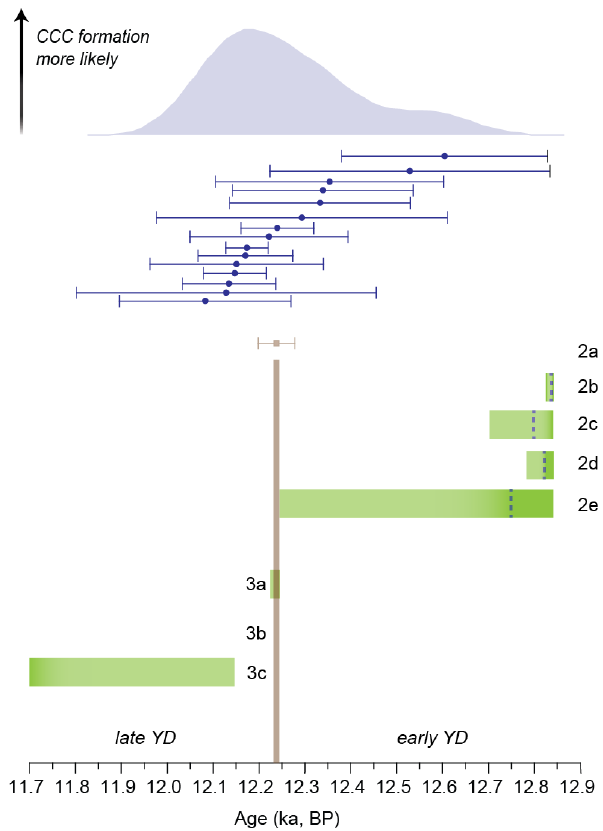
Figure 5. 230 Th ages of CCCs with their 2 σ uncertainties from Cioccherloch (blue bars) and CCC formation “windows” as sug- gested by model scenarios for the early and late YD. Peaks of kernel density calculated from the 230 Th ages show the likelihood of CCC formation (blue shaded area). The green bars mark the − 1 to 0 ◦ C window of possible CCC formation at the depth of the CCC site. The blue dashed vertical lines mark the − 0 . 5 ◦ C isotherm at 50m of depth (2c–2e). The brown vertical line and age with the 2 σ error bar mark the timing of the mid-YD transition at Meerfelder Maar (Lane et al.,